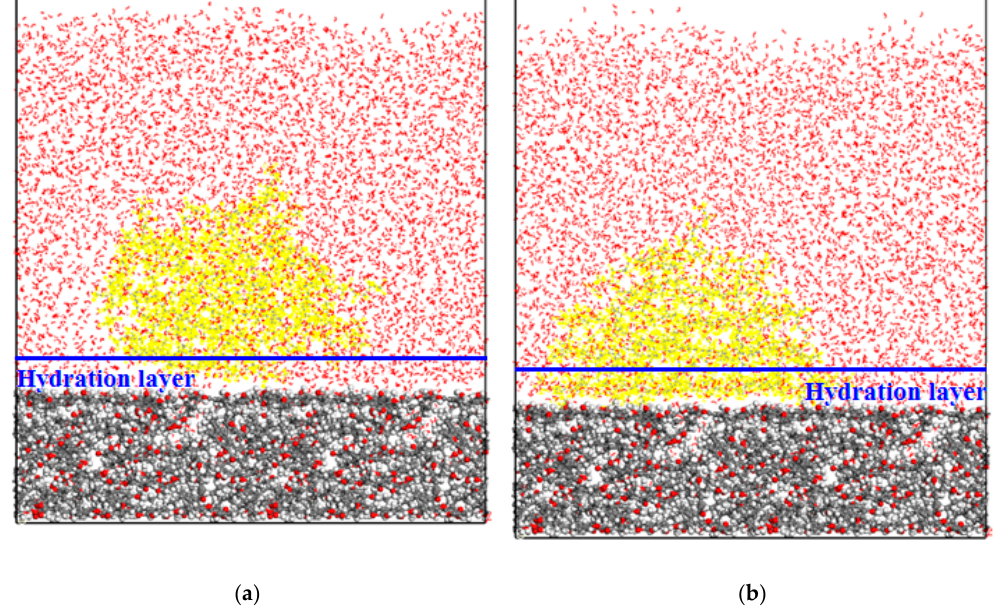
Figure 9. Initial ( a ) and final ( b ) configurations of the CWC adsorption system.